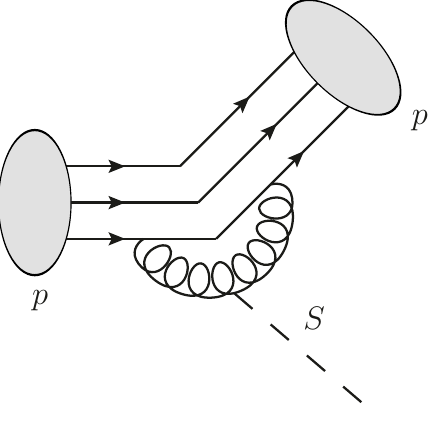
Figure 2 . An example of a diagram for the e(cid:11)ective interaction of a proton with a scalar,